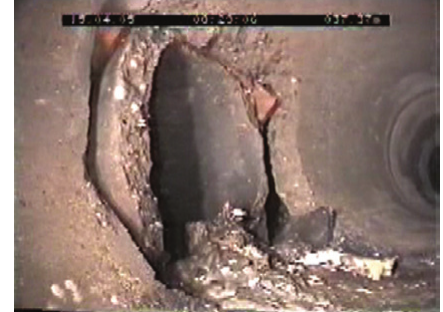
Fig. 7. Defective connection with visible air voids beyond the sewer wall